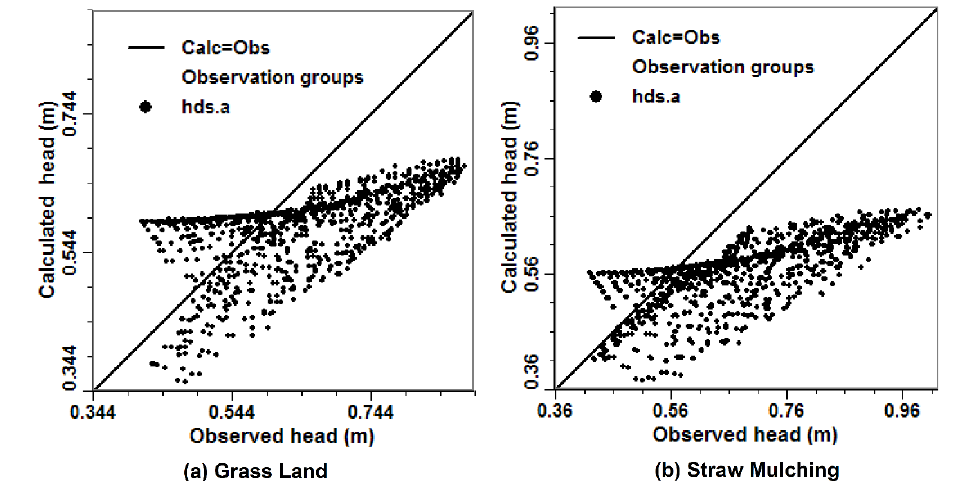
Figure 5. The scatter graph of the calculated vs. observed values based on the calibrated parameters for different underlying surface: ( a ) Grass Land; ( b ) Straw Mulching. The groundwater heads are shown as dots and the solid lines mean the calculation heads are equal to the observed